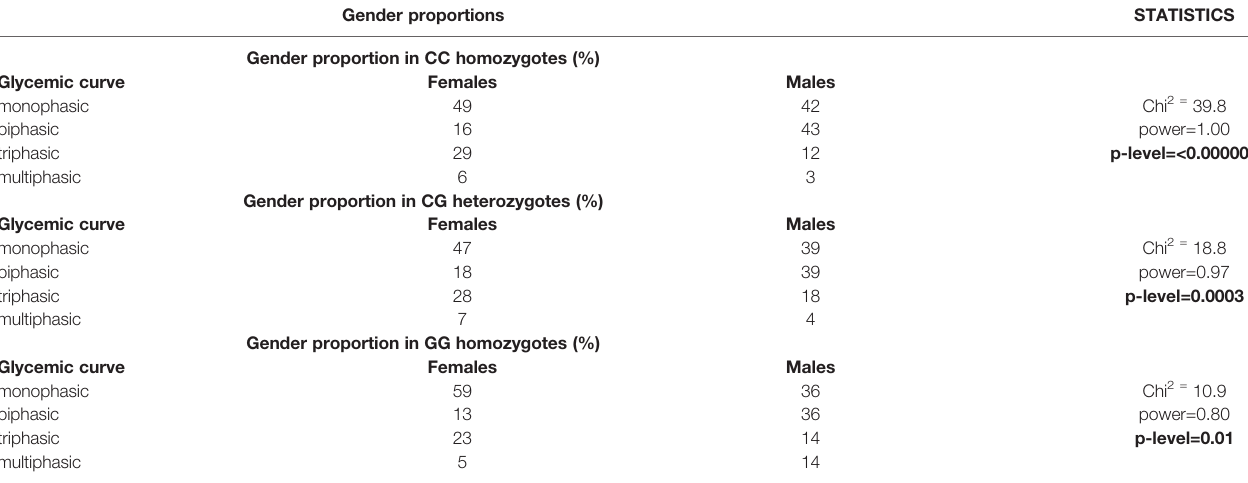
TABLE 5 | Gender proportions depending on the MTNR1B rs10830963 genotype and on the shape of glycemic